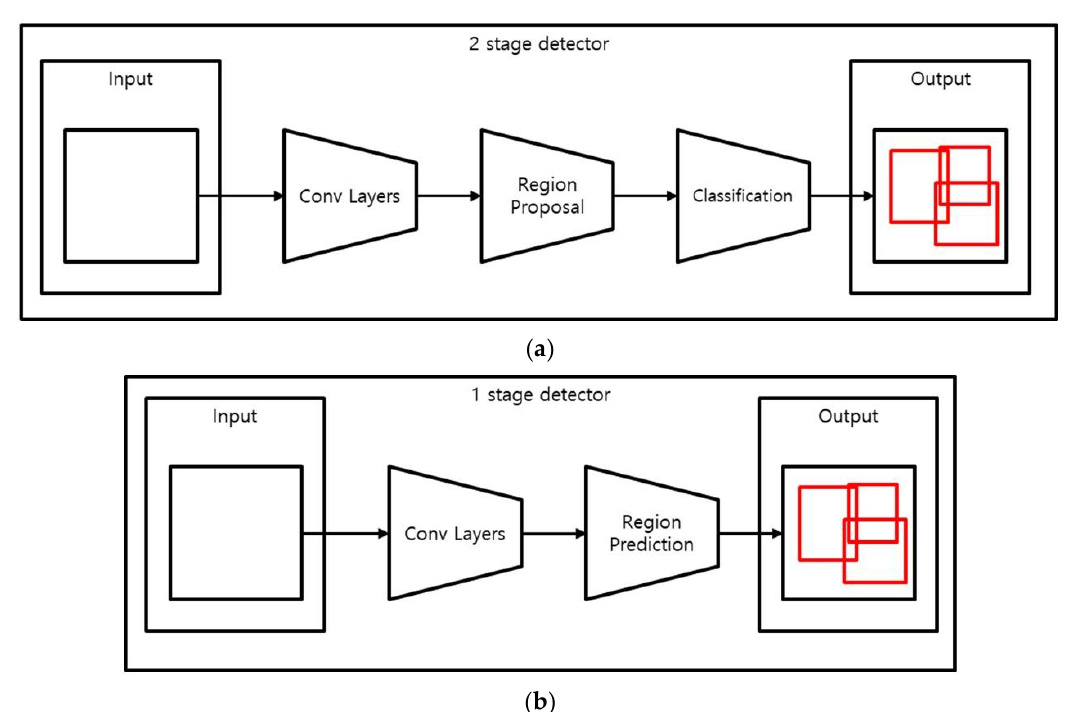
Figure 10. Generalized object detection architecture: ( a ) two-stage detector and ( b ) one-stage detector.